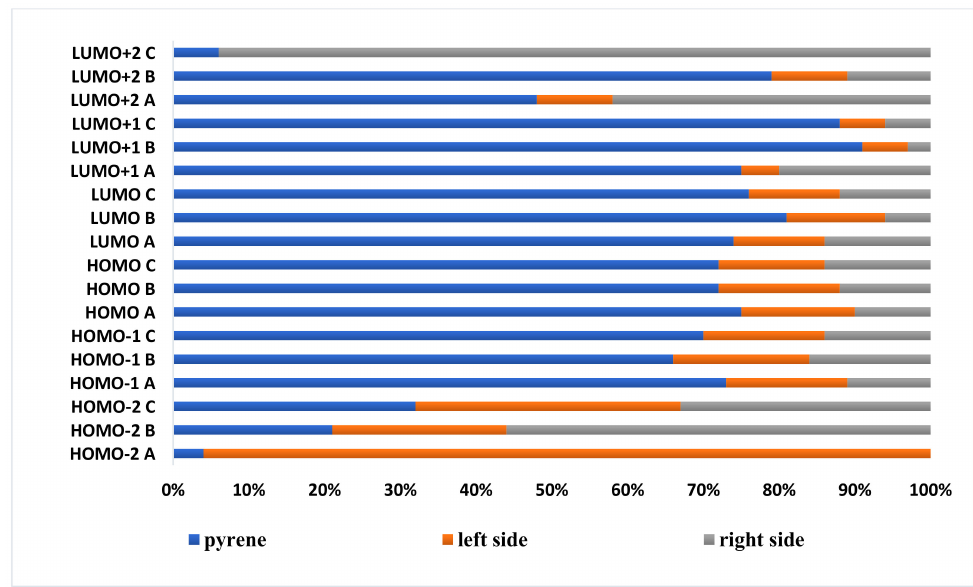
Figure 2. Contribution of the particular parts of the molecules creating orbitals HOMO-2, HOMO-1, HOMO, LUMO, LUMO+1 and LUMO+2 for A – C